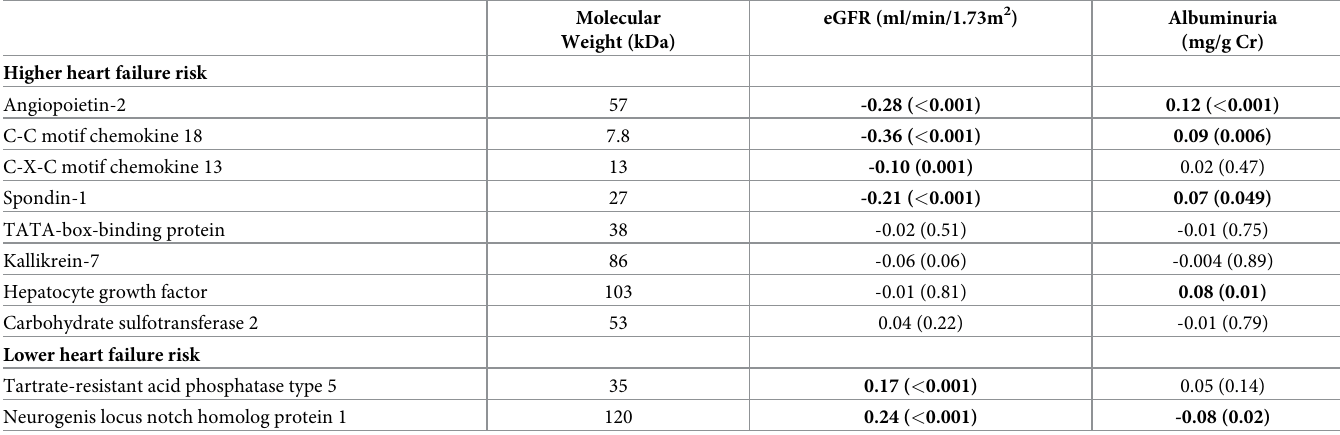
Table 3. Pearson’s correlation coefficients between proteins predicting heart failure and egfr, or albuminuria in full sample �